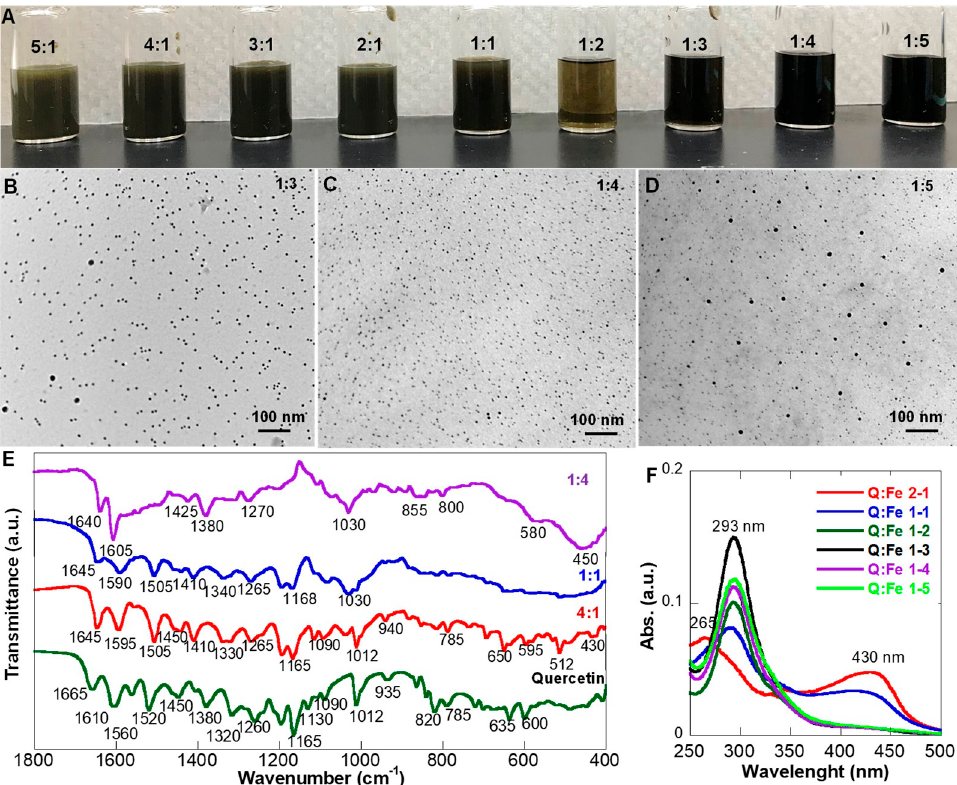
Figure 3. Ratio effect on NP formation: ( A ) photos of the reaction solutions at different ratios with different turbid levels; ( B – D ) representative TEM images of samples with NP formation at Q-Fe ratios of 1:3, 1:4, and 1:5; ( E ) FTIR spectra of representative samples with/or without NP formation; and ( F ) UV-Vis spectra of samples with NP formation at different ratios.